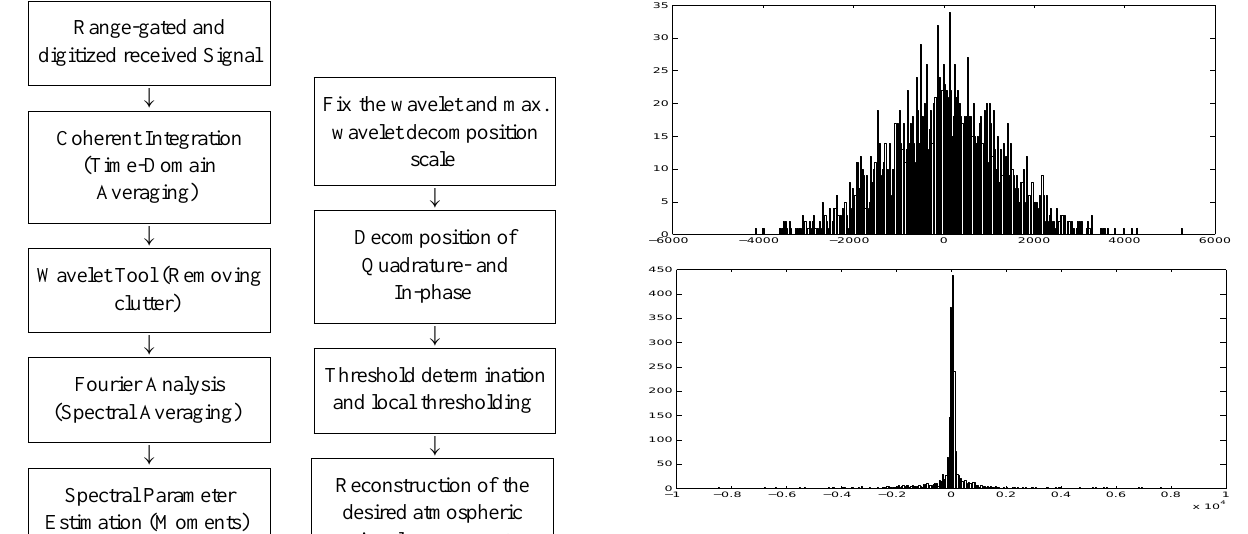
Fig. 6. This figure shows typical histograms of the wavelet coeffi- cients (see text). The upper histogram represents an in-phase series without an airplane echo and the lower histogram represents an in- phase series with an airplane